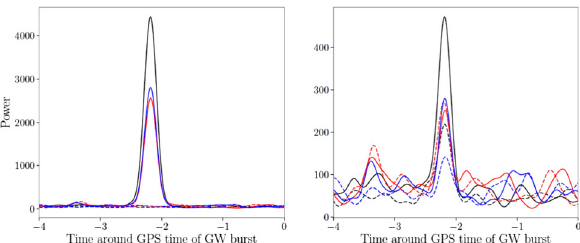
Fig. 3 Arrival times of left-hand (solid lines) and right-hand polariza- tion (dashed lines) signals at (90,110)Hz. Left panel shows the results of face-on GW events, and right panel shows that of edge-on events. The black lines show the results of the GW event as in Fig. 2, and the red and blue lines show the results of other two samples respectively. Note that, in this figure, the vertical axis stands for the strength of power in Fig.